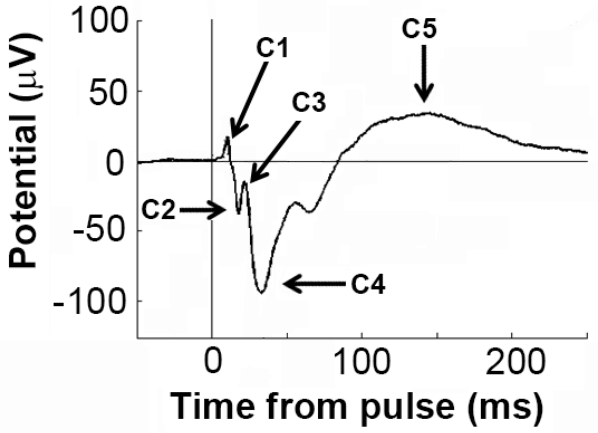
Figure 2. Representative ERP showing different wave components for